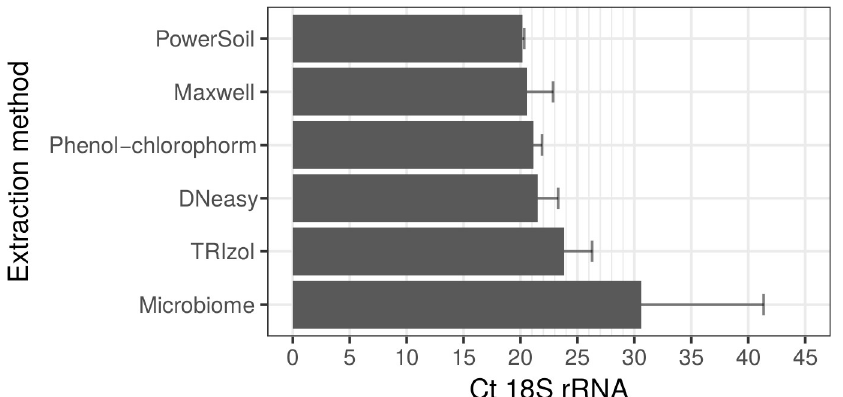
Fig 4. Ct values for mammalian target (18S rRNA) amplified by qPCR from infected mouse footpad tissue extracted by different DNA extraction procedures. Data are displayed as mean plus standard deviation (SD) from batches processed independently. All kits were analyzed in triplicate with the exception of Microbiome, which was analyzed in